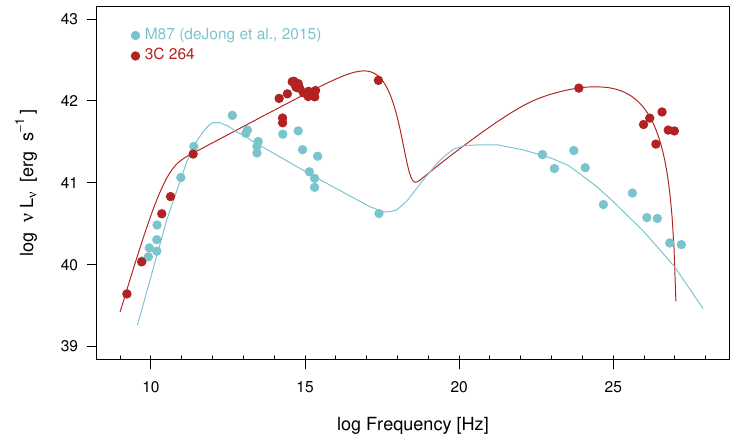
Figure 4. Taken from [109], a broadband SED for 3C 264 compared against that of M87. Unlike the SED of M87, which for a radio galaxy appears consistent with that expected according to the blazar sequence, the SED for 3C264 shows a relatively high-frequency synchrotron peak near the X-ray frequency band ( ∼ 10 17